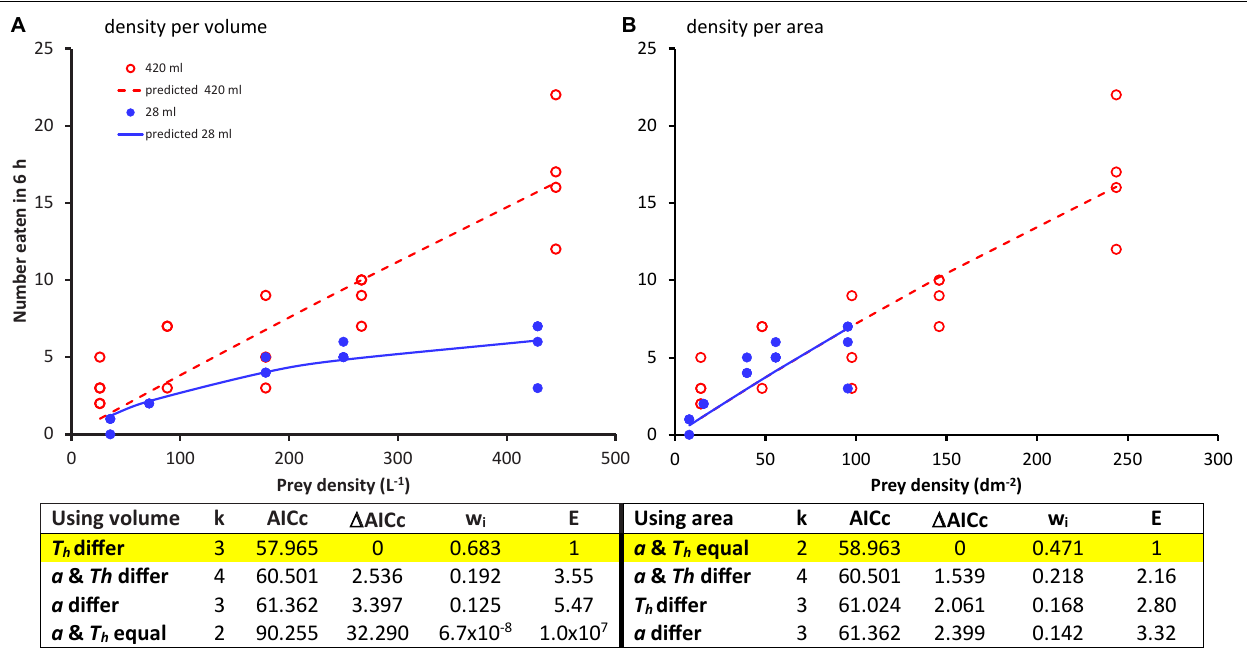
FIGURE 1 | Number of prey eaten per predator per 6 h experiment vs. prey density based on (A) . water volume and (B) . surface or bottom area. Points are observed values and lines are the predicted functions for the most plausible model in each analysis. For comparisons of the different models: k is the number of parameters, w i is the Akaike weight for each model, and E is the evidence ratio (Anderson, 2008). Estimated parameters (95% confidence interval): (A) . Volume: Equal a , T h differ: a = 0.0066 (0.0040, 0.0092) L/h, T h ( small ) = 0.6302 (0.2852, 0.9753) h, T h ( large ) - T h ( small ) = − 0.6088 ( − 0.9039, − 0.3138) h. (B) . Area: Equal a